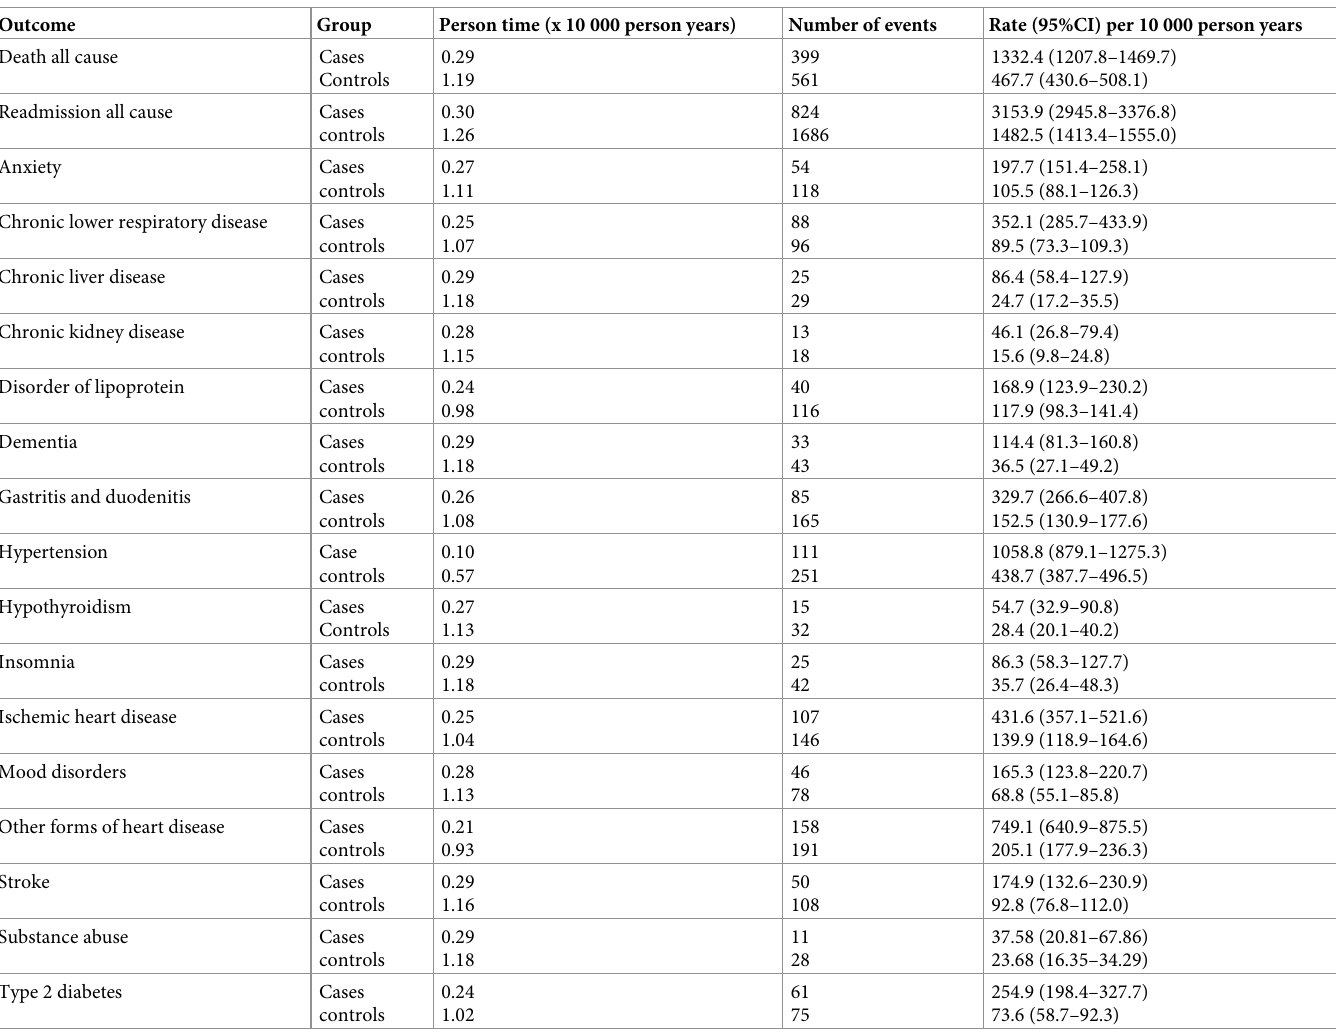
Table 2. Rates of incident outcomes (events per 10 000 person years) among patients who were hospitalized with COVID-19 and a matched general population con- trol in Estonia